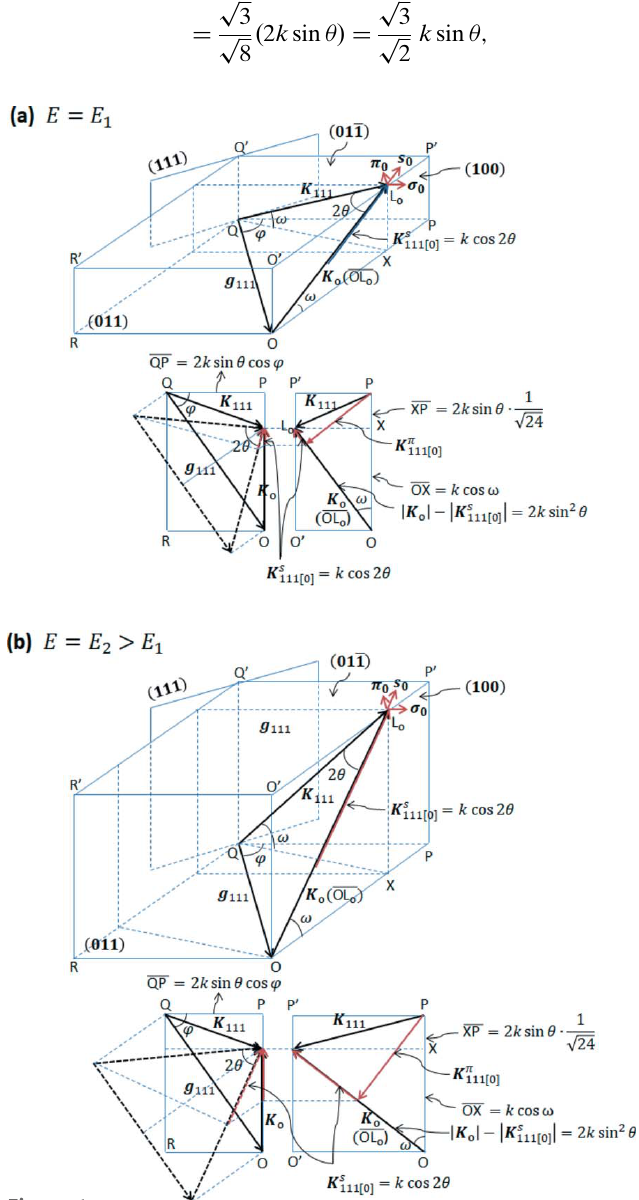
Figure 1 Schematic of 111 ; (cid:2) 1111 = 200 three-beam multiple diffraction in reciprocal space of Ge, where only the 111 reflection is represented, considering the (cid:2) 1111 beam travels in a symmetrical direction with the plane of symmetry (100) at incident X-ray energies of E = E 1 in ( a ) and E = E 2 (> E 1 ) in ( b ) with rectangles OPQR and PP 0 O 0 O representing projections on the 01 (cid:2) 11 (cid:4) (cid:5) and (100) planes, respectively. 01 (cid:2) 11 (cid:4) (cid:5) : entrance surface; K o : incident X-ray wavevector; K 111 : 111-reflected X-ray wavevector; g 111 : diffraction vector of the 111